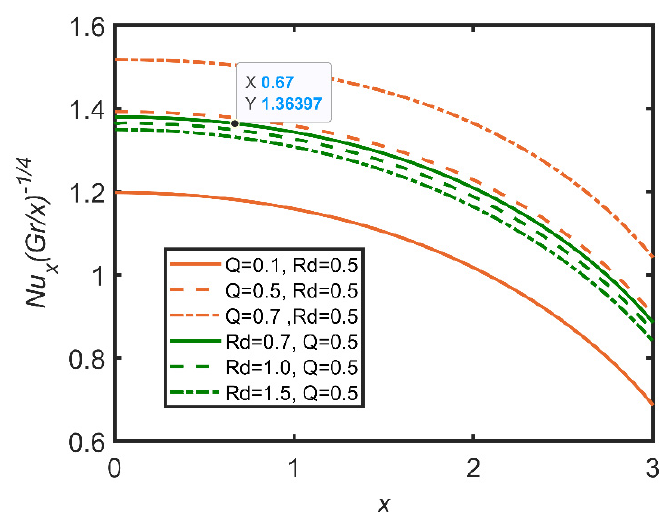
Figure 15. Comparison for skin friction against x.